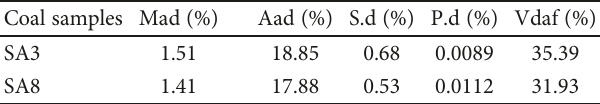
Note: Mad: moisture content; Aad: ash content; S.d: sulfur content; P.d: phosphorus content; Vdaf: volatile matter, ad: air dried condition, daf: dry ash free